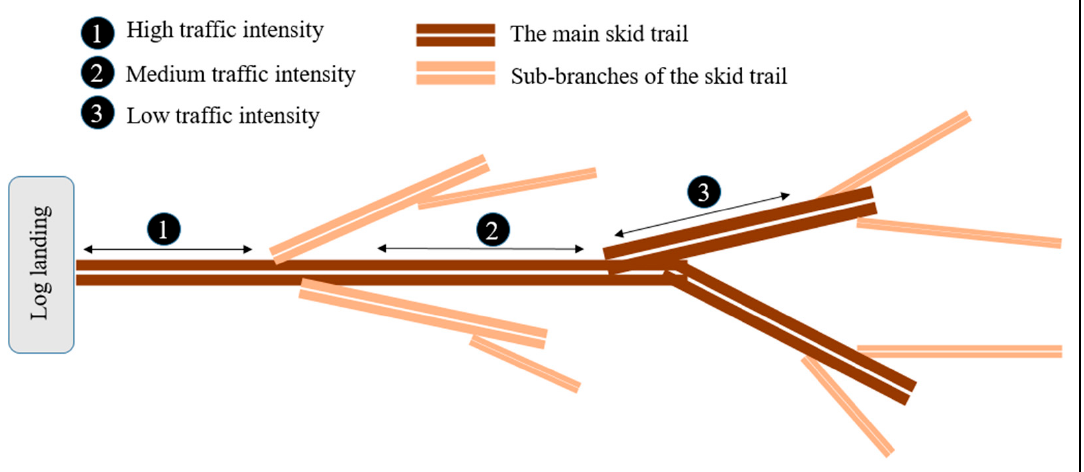
Figure 2. Skid trail with different traffic intensities.